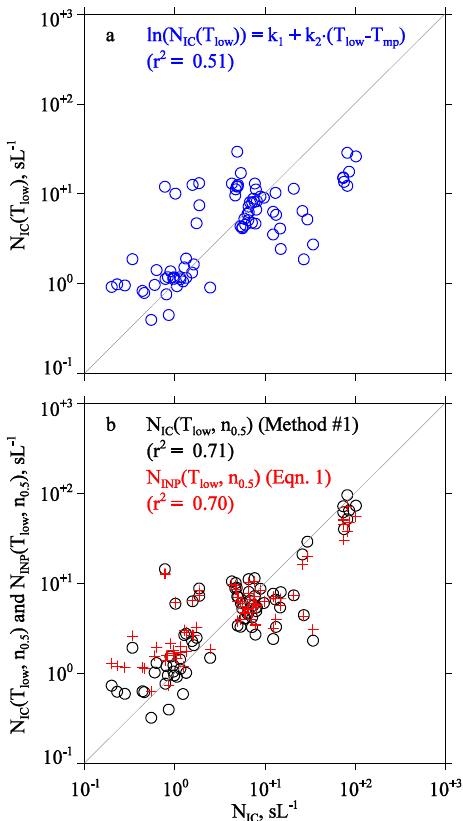
Figure 3. (a) Values of N IC (T low ) (ln( N IC (T low )) = k 1 + k 2 · (T low − T MP ) with T MP = 273.15K, k 1 = − 4.04 and k 2 = − 0.22 ◦ C − 1 ) plotted versus measured N IC . (b) As in Fig. 3a but with N IC (T low , n 0 . 5 ) (method 1 fit coefficients) and N INP (T low , n 0 . 5 ) (Eq. 1 with D10’s coefficients) plotted versus measured N IC . In (a) and (b) , the square of the Pearson correla- tion coefficients ( r 2 ) was evaluated using log-transformed concen- trations. Also, the one-to-one line is shown in both